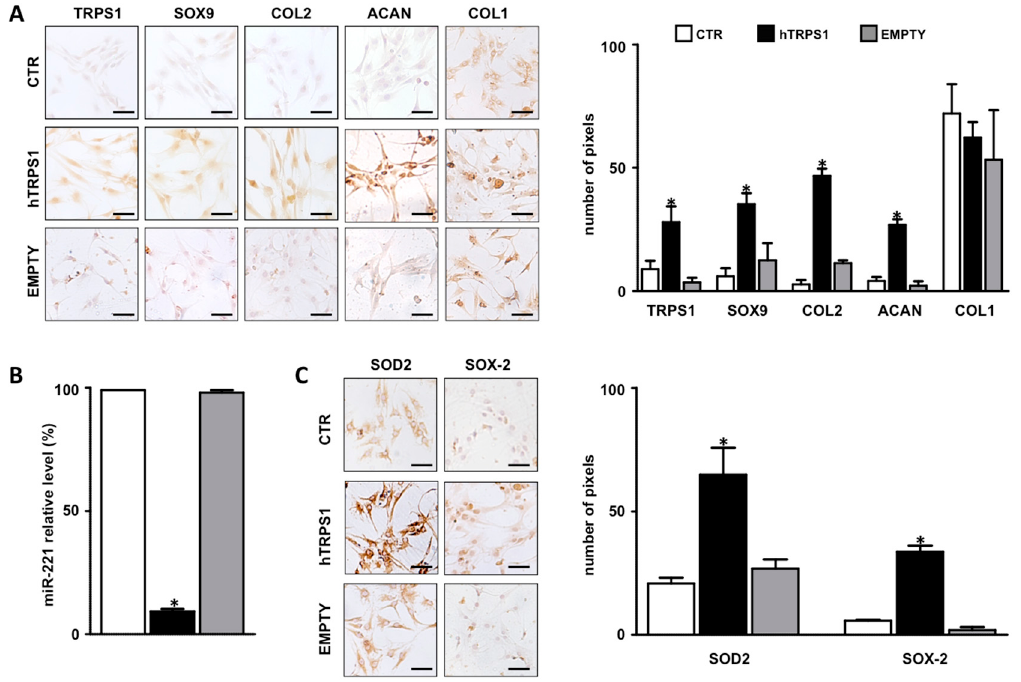
Figure 2. Evaluation of the effect of TRPS1 overexpression on IVD cells. Cells were transfected with the vector containing the full-length human TRPS1 cDNA (black column), with the empty vector (gray column) or remained untreated (CTR, control, white column) and harvested after 48 h. The expression of differentiation markers ( A ), miR-221 ( B ), antioxidant defense and stemness markers ( C ) were evaluated. Representative optical photomicrographs of TRPS1, COL2, SOX9, ACAN, COL1, SOD2 and SOX-2 respectively immunostaining is reported. Protein levels were quantified by densitometric analysis of immunocytochemical pictures using ImageJ software and expressed as means of pixels per one hundred cells ± SD ( n = 10). * = p < 0.01. Scale bars: 20 µm. The expression levels of miR-221 were measured by qRT-PCR by the 2 ( − △△ Ct) method. Data are presented as fold changes relative to control untreated cells ± SD ( n = 10). * = p < 0.01 (hTRPS1 treatment vs. CTR and empty).